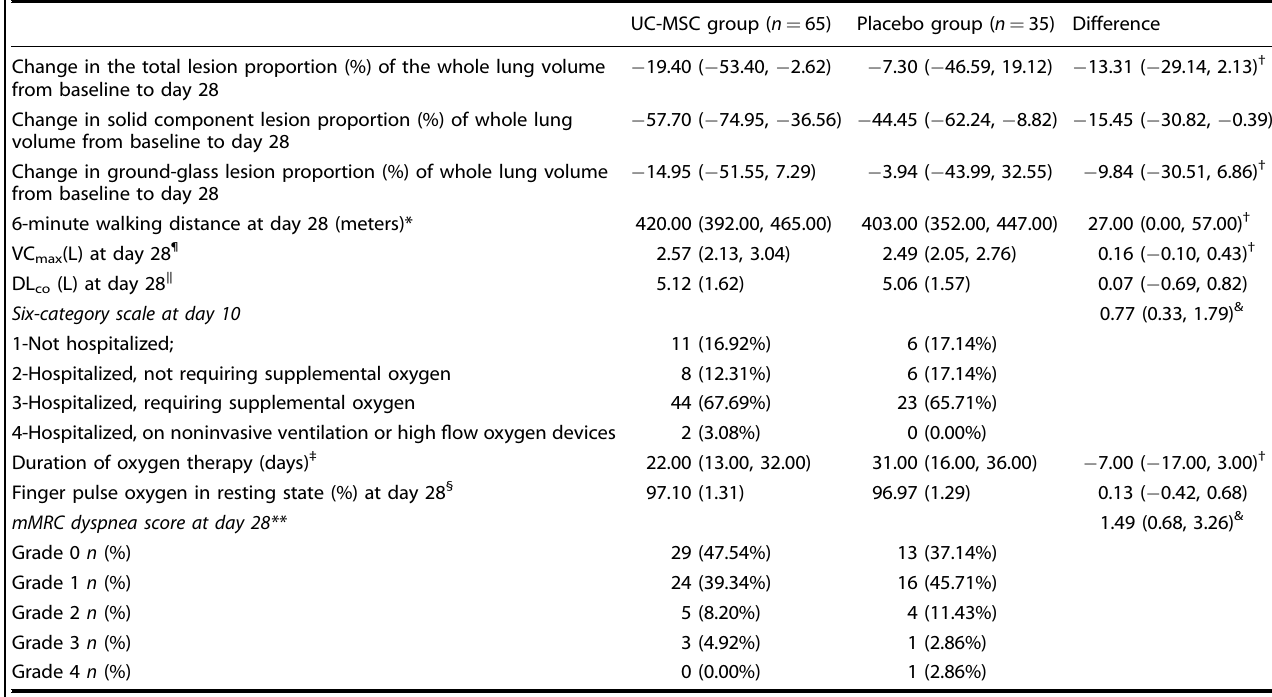
UC-MSC group ( n = 65) Placebo group ( n = 35) Difference